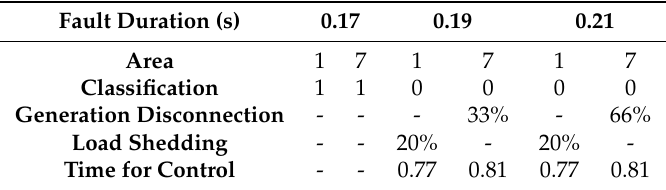
Table 1. Results for the fault in Line 4-5.